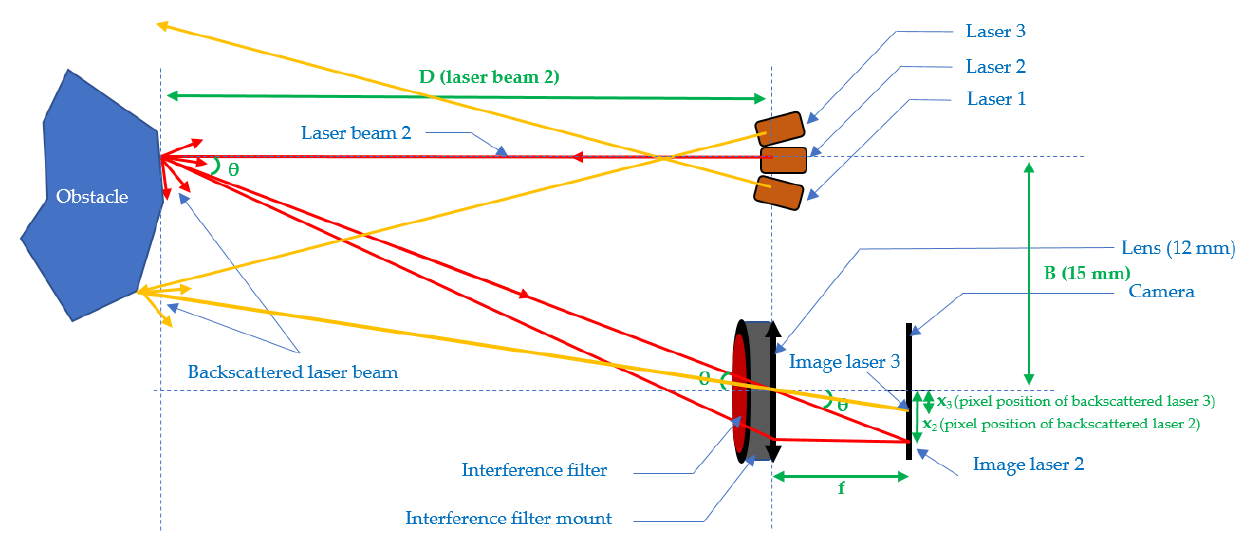
Figure 2. Basic scheme of the setup with three laser beams .